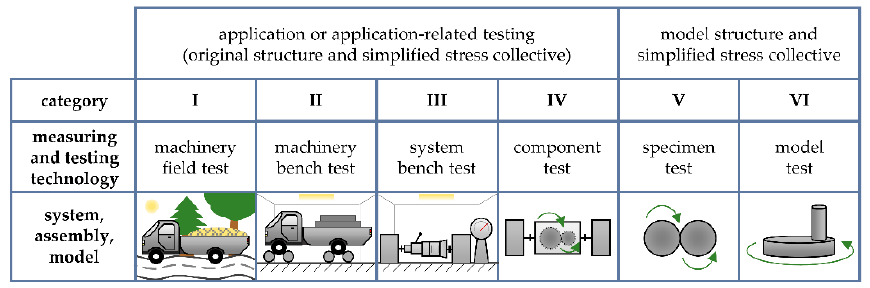
Figure 2. Categories of tribological testing. Redrawn from [13].